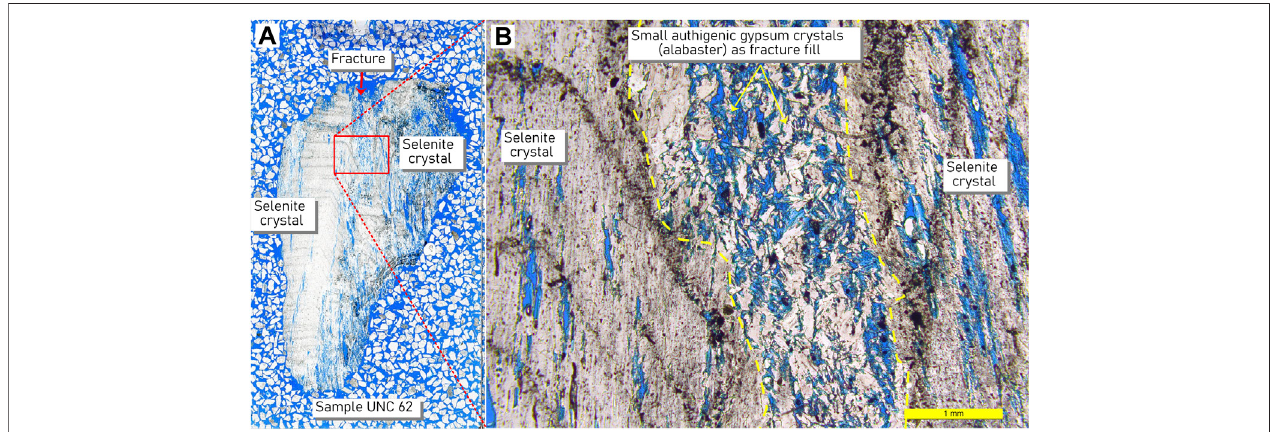
FIGURE7| Petrographicthinsection showinggrowthfrontsinselenitecrystalhabit. (A) Scanofpetrographic thinsection. (B) Close-upofareawithinredboxinA. Selenitecrystalwithgrowthfrontsandsmallpatchesofalabasterwithslotpores.Suchgrowthfrontswere ≤ 2 mmthickandcomprisedanopaqueblacklayerseparating layers of selenite gypsum. Pores can be fi lled with intraclastic gypsum grains, secondary gypsum crystals, and/or volcanic detritus and may be adjacent to alabaster domains. Slide background is a mixture of mineral grains to show slide thickness during